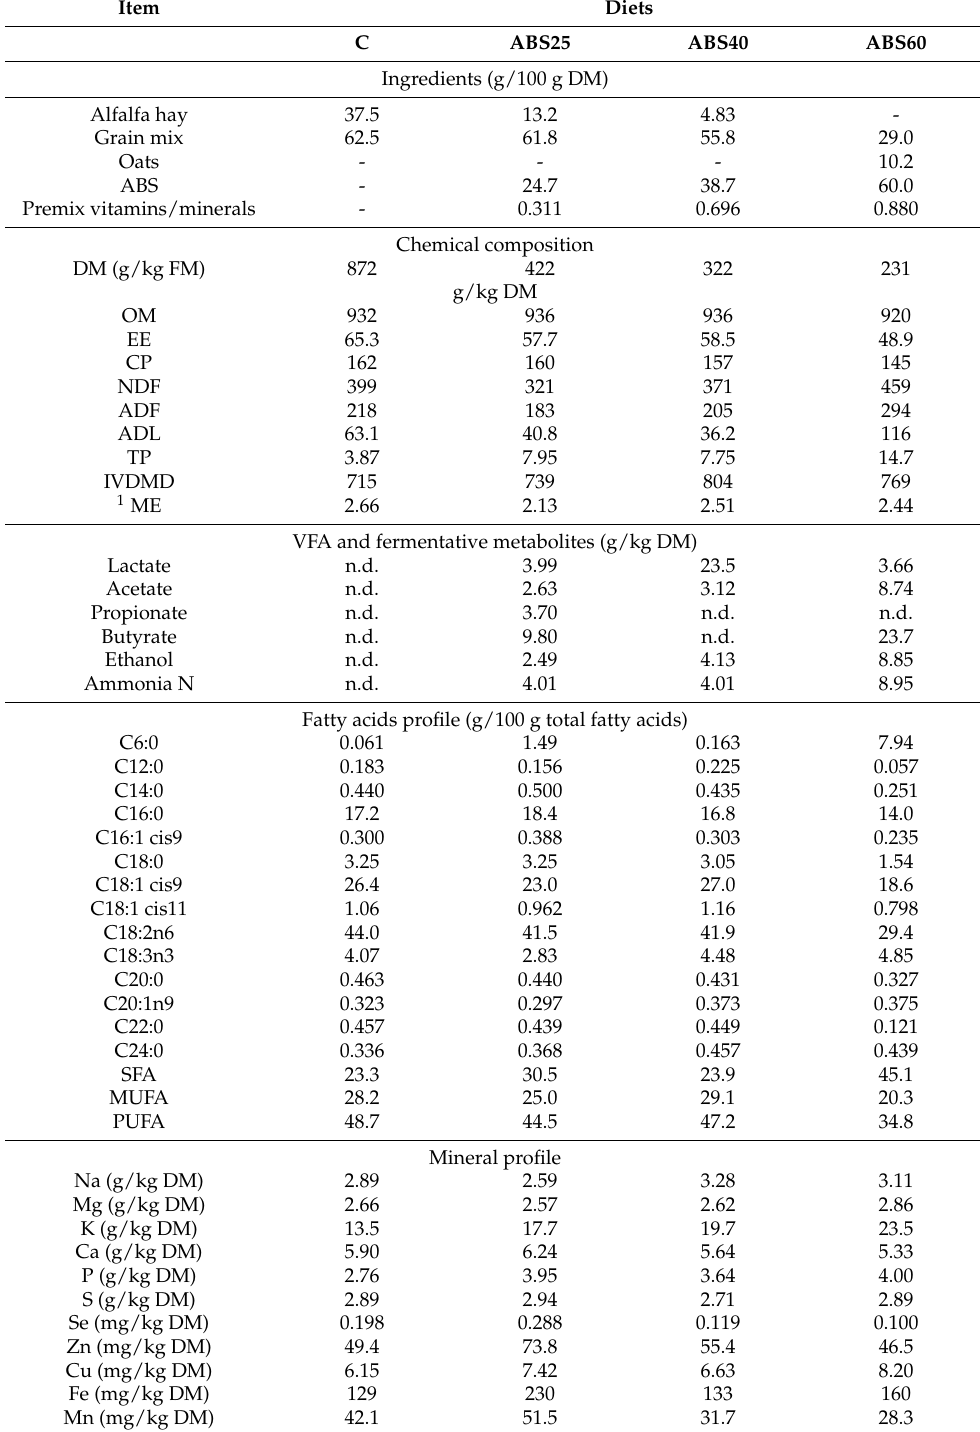
Table 1. Ingredients and chemical composition of experimental